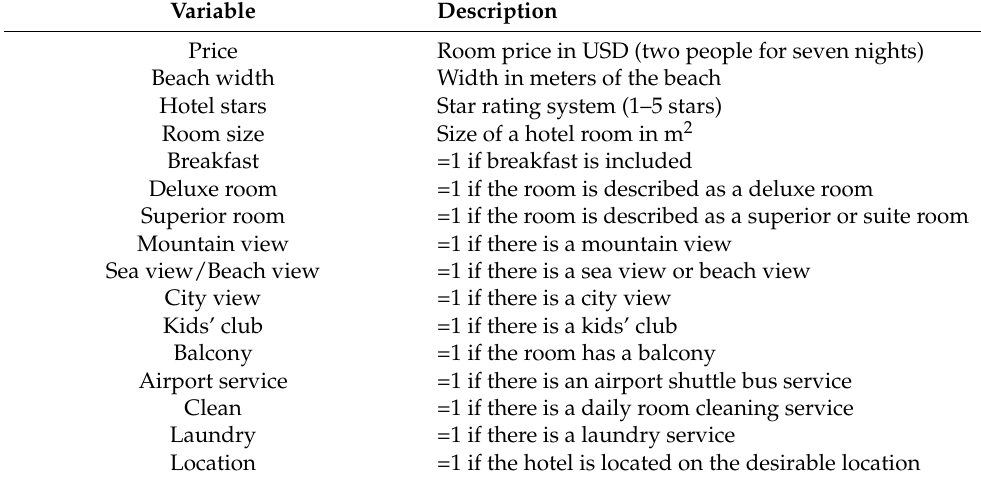
Table 4. Hotel attribute